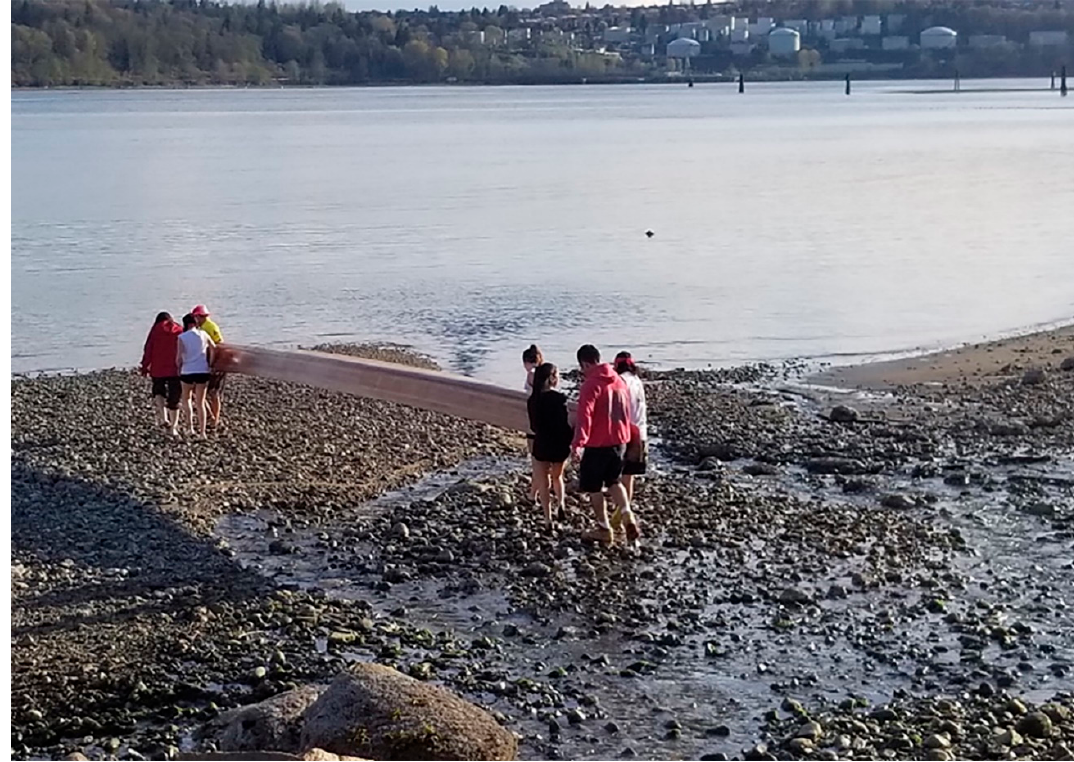
Figure 1. The canoe photo (Photo Credit: Kevin O’Neill).